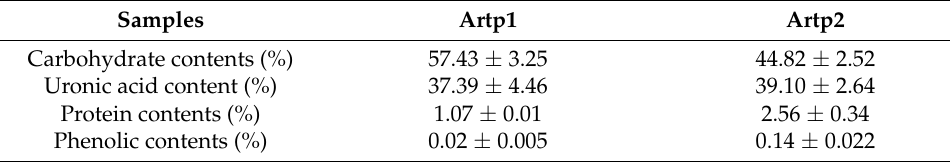
Figure 1. The DEAE-52 cellulose column chromatograms of Artp1 and Artp2 ( A ), HPAEC-PAD chromatogram profiles of standard monosaccharide mixture solution ( B ), and the monosaccharides from Artp1 ( C ) and Artp2 ( D ). Table 1. The chemical compositions of Artp1 and Artp2.